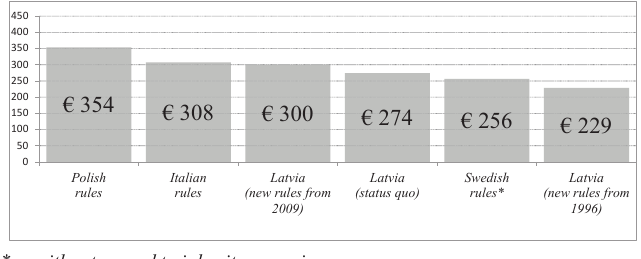
Fig. 2. Theoretical net pension benefit for an average wage earner with a 40-year record depending on methodology of notional capital valorisation.